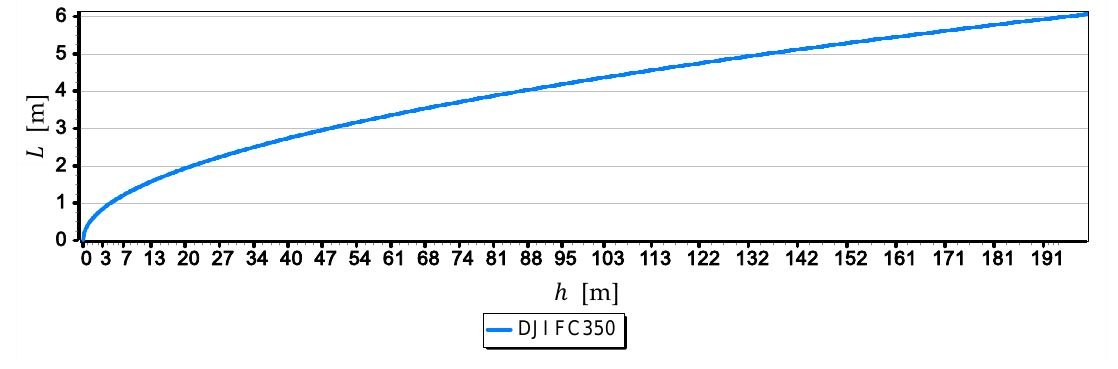
Figure 10. Single-pixel measurements resolution 𝐿 of the horizon line as a function of the height of the DJI FC350 camera a.s.l. ℎ ( 𝑓 = 14 mm).